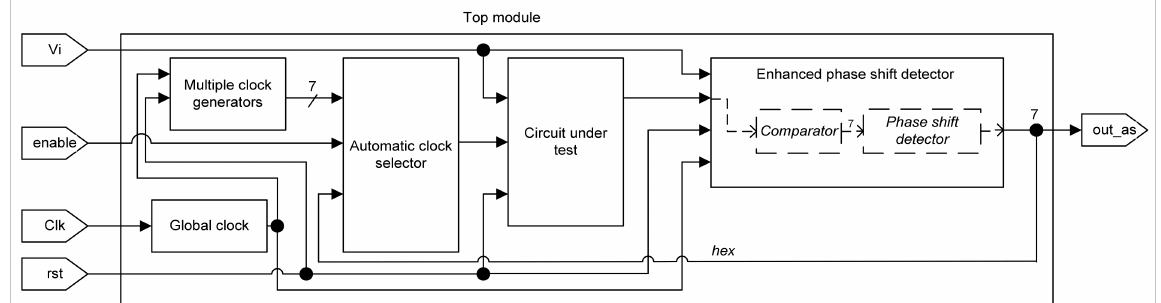
Figure 9. Block diagram for automatic clock